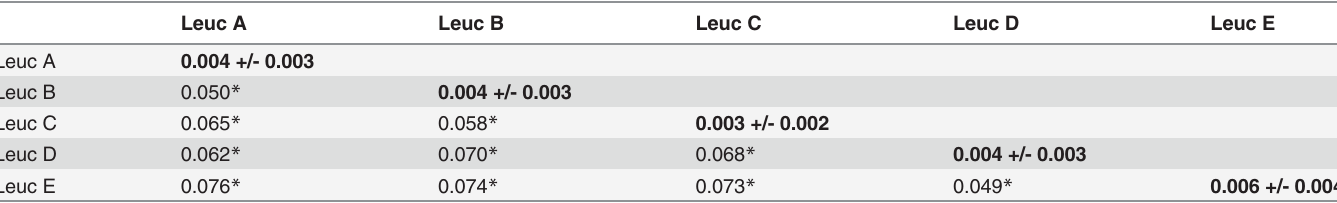
Table 4. Genetic distances between clades of Leucocytozoon haplotypes sequenced in this